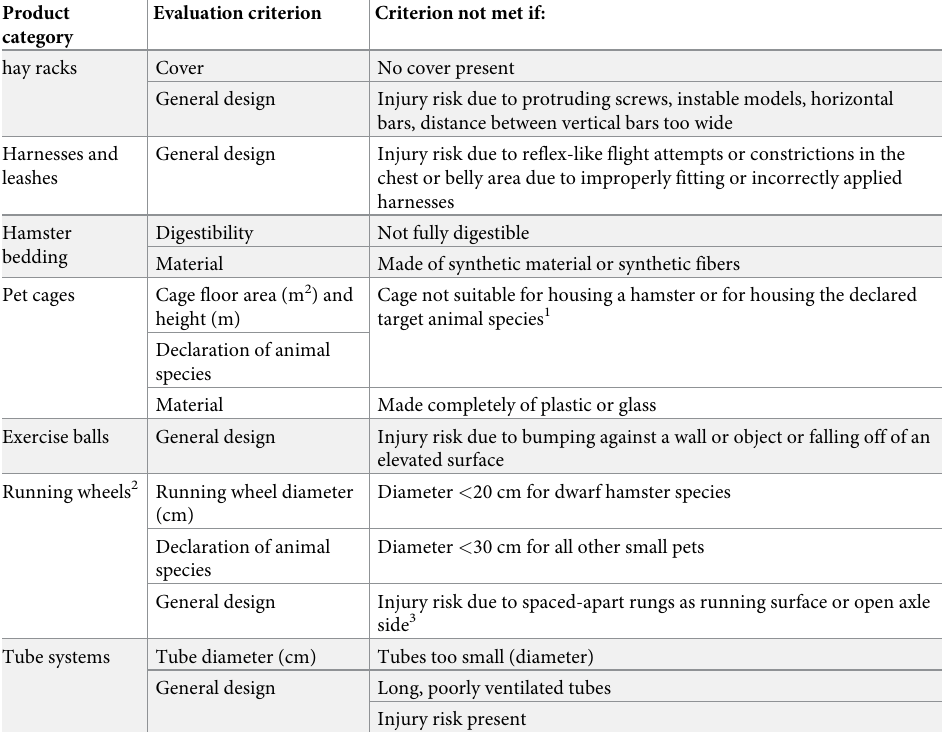
Table 1. Product-group-relevant and applied criteria to evaluate animal welfare compliance of accessories offered for small mammal pet husbandry. Basis for the evaluation were the German Animal Welfare Act [8], Fact Sheet No. 62 from the “Veterinary Association for Animal Protection” (Tiera¨rztliche Vereinigung fu¨r Tierschutz e. V. [30]), and the position paper from the “German Animal Welfare Association” (Deutscher Tierschutzbund e. V. [31]). Product